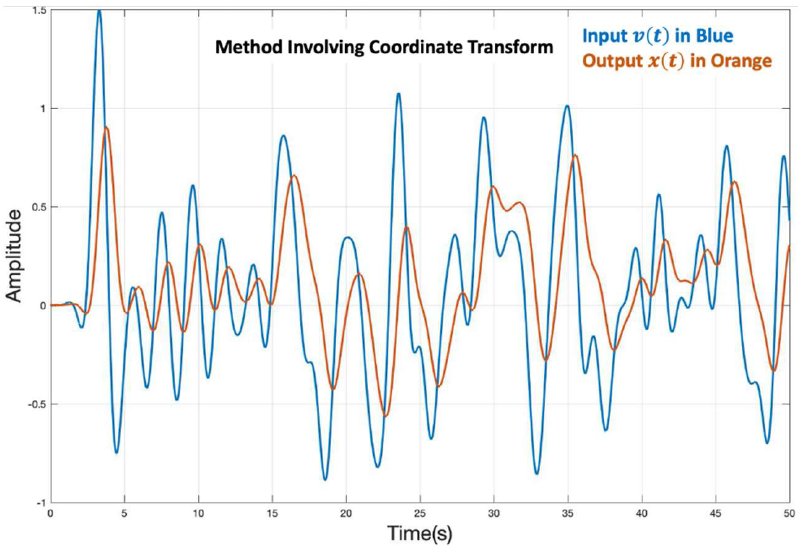
Figure 18. Response to Randomized Input (Techniques 2 and 3).